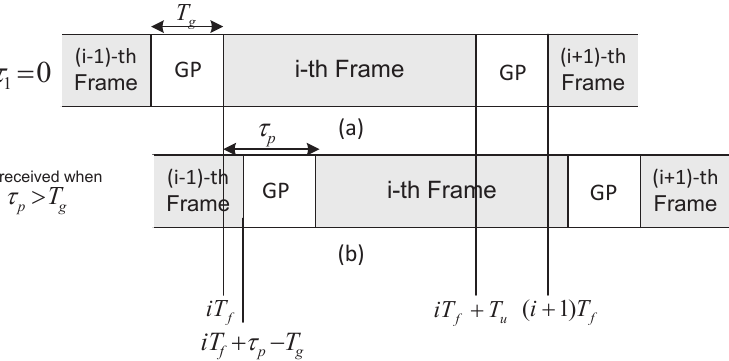
Figure 3. ( a ) Received frame from the shortest multipath component and ( b ) Received frame from the p -th path with τ p > T g